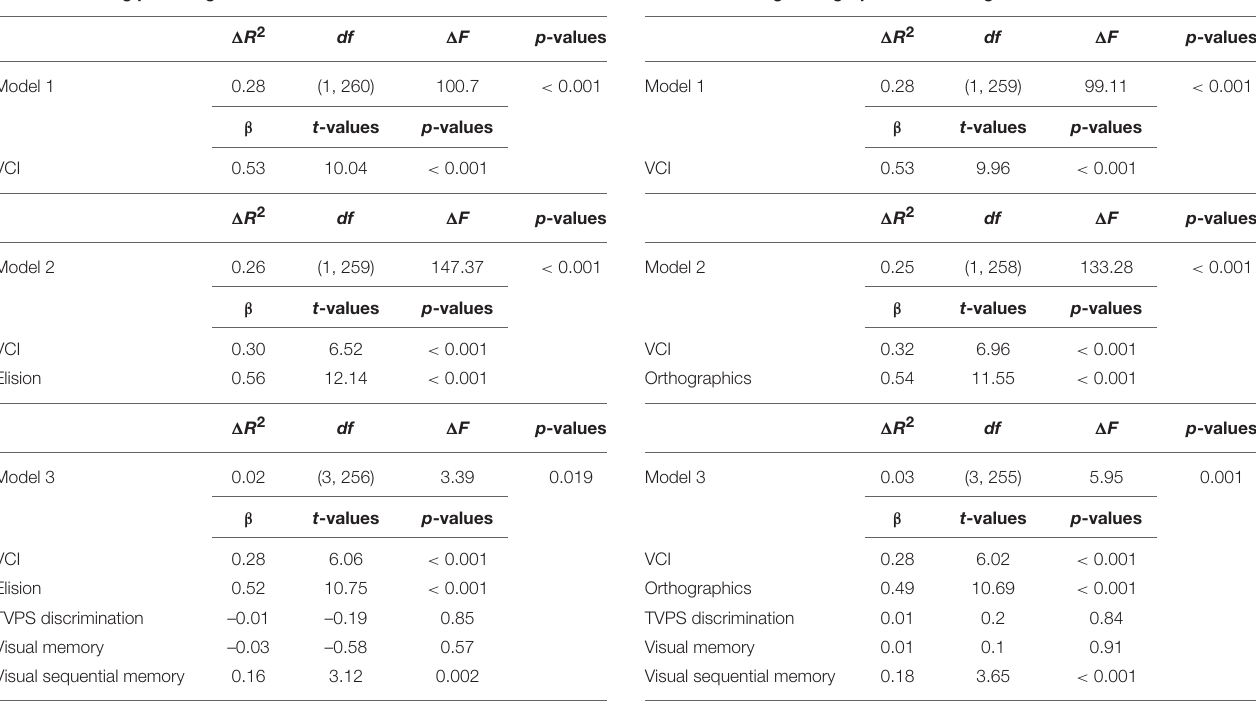
TABLE 4 | Hierarchical regression predicting basic reading performance when controlling orthographic